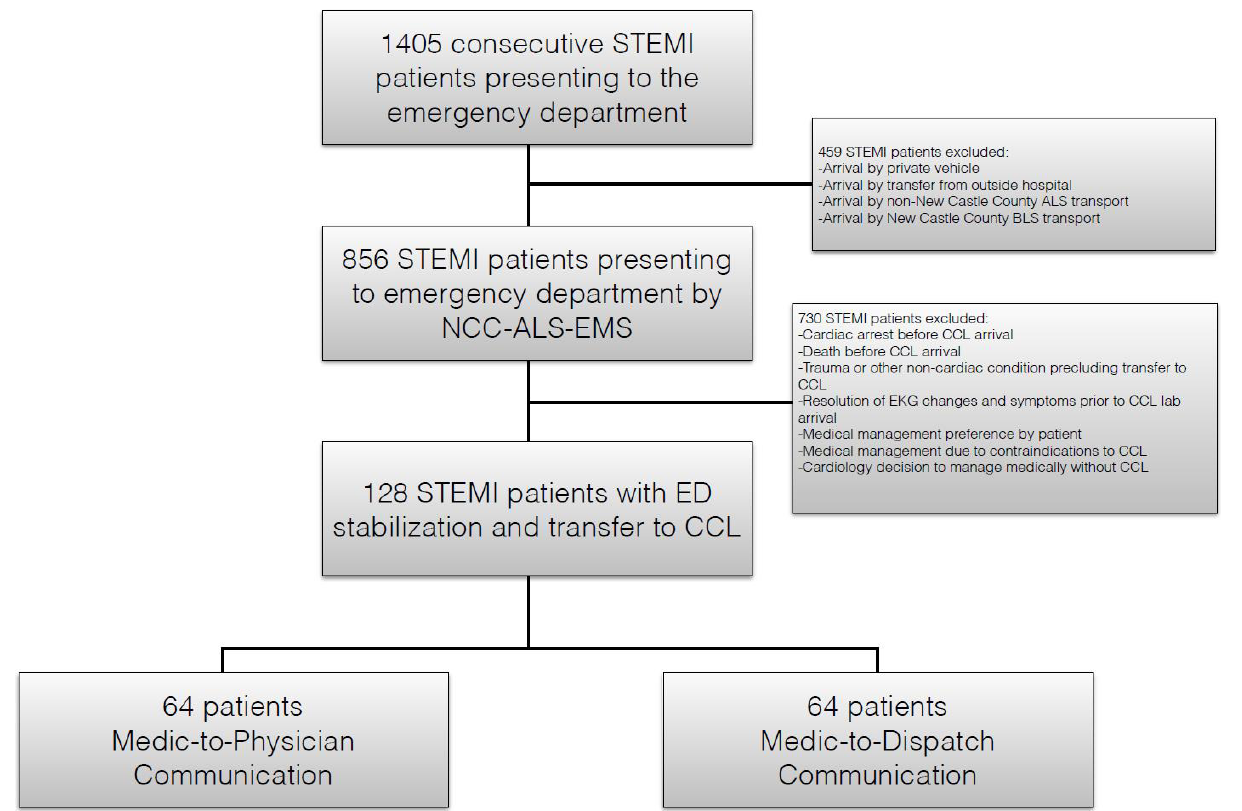
Figure 2. Enrollment flow chart with exclusions. STEMI, ST-elevation myocardial infarction, NCC-ALS-EMS, New Castle County-advanced life support-emergency medical services, ED, emergency department; CCL, cardiac catheterization lab; BLS , basic life support; EKG,